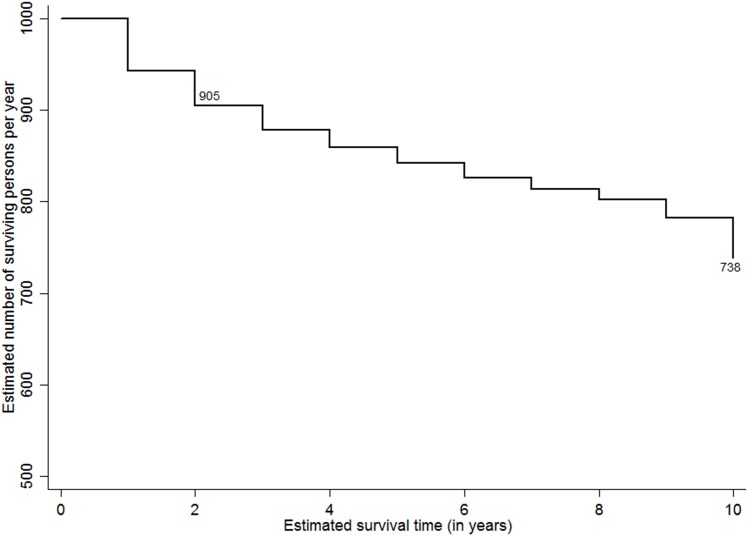
Adjusted Kaplan-Meier survival estimates (per 1000 persons per year).The line graph shows ten-year survival probability curves among PLHIV per 1000 persons per year since they tested positive for HIV at the overall level. The estimates are adjusted by the place of residence.